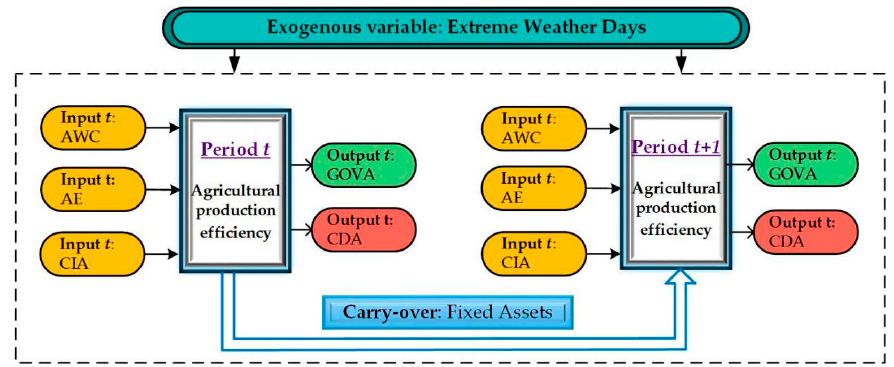
Figure 1. The Slacks-Based Measures (SBM) dynamic model.